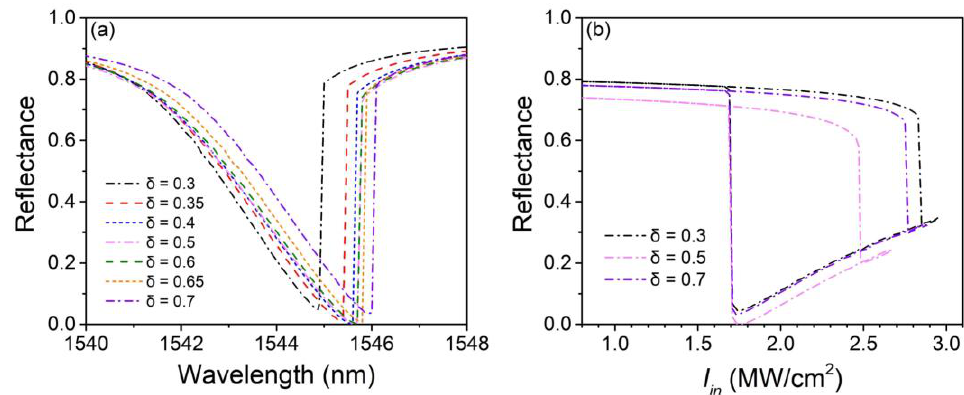
Figure 6. ( a ) Nonlinear reflectance spectrums with different grating width-to-period ratio δ . ( b ) Hys- teresis loops with δ = 0.3, 0.5, and 0.7, respectively.